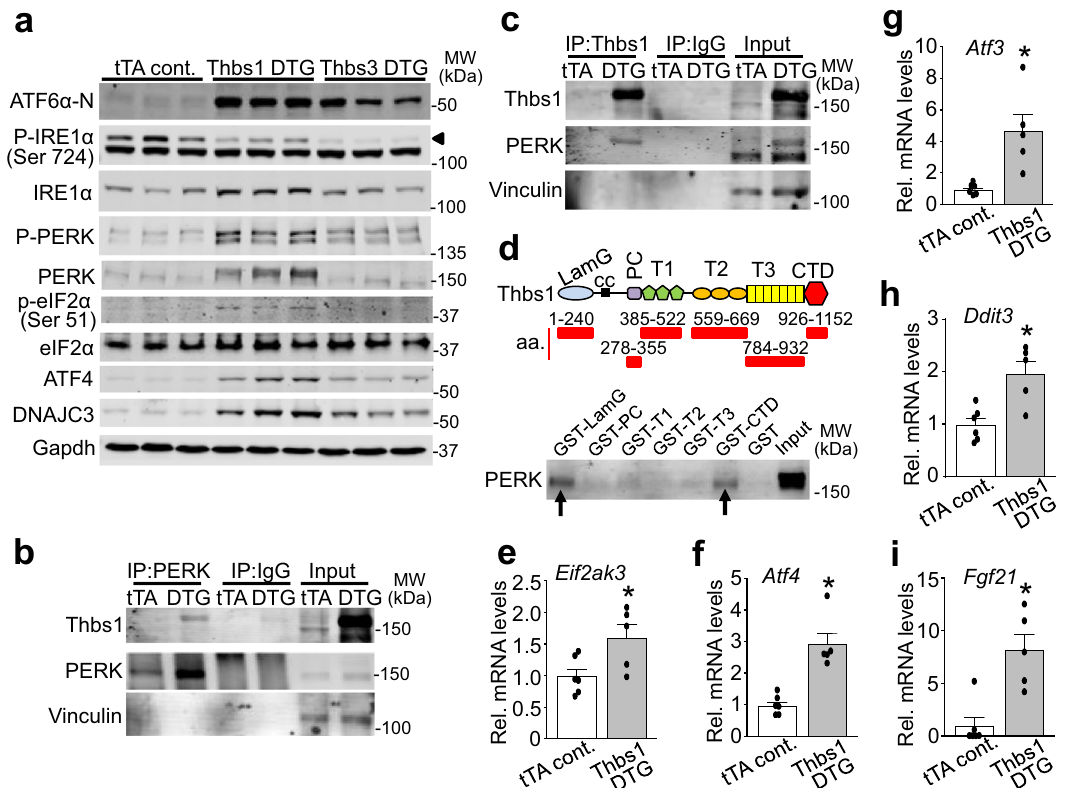
Fig. 4 Thbs1 binds and activates a PERK-mediated ER stress response. a Representative western blots for ATF6 α -N (50 kDa, nuclear), phospho-IRE1 α (Ser 724; arrowhead), total IRE1 α , phospho- and total PERK, phospho-eIF2 α (Ser 51), total-eIF2 α , ATF4, and DNAJC3. Phospho-PERK was analyzed using Phos-tag gels. The heart protein extracts are from the indicated mice at 4 weeks of age. Gapdh serves as a processing and loading control. b , c Western blot for Thbs1 and PERK following immunoprecipitation (IP) of PERK ( b ) or Thbs1 ( c ) from protein extracts of tTA cont. and Thbs1 DTG hearts at 6 weeks of age. IPs with corresponding IgG served as negative controls. Vinculin is an input loading control. d Schematic diagram of Thbs1 with the GST-Thbs1 fusion proteins regions shown (red bars). Below the schematic a representative western blot for PERK following GST pull-down with the different Thbs1 domains from primary neonatal rat ventricular cardiomyocyte extracts. GST protein serves as a negative control. e - i , Quantitative RT-PCR for Eif2ak3 (PERK protein; * P = 0.0317 vs tTA control), Atf4 (* P = 0.0006 vs tTA control), Atf3 (* P = 0.0058 vs tTA control), Ddit3 (Chop protein; * P < 0.0001 vs tTA control)) and Fgf21 (* P = 0.0023 vs tTA control) from mRNA isolated from hearts of tTA cont. (n = 6 biologically independent animals) and Thbs1 DTG mice (n = 5 biologically independent animals) at 6 weeks of age. Statistical analysis was performed using two-tailed Student ’ s t test. Error bars are ±standard error of the mean. Source data are provided as a Source Data